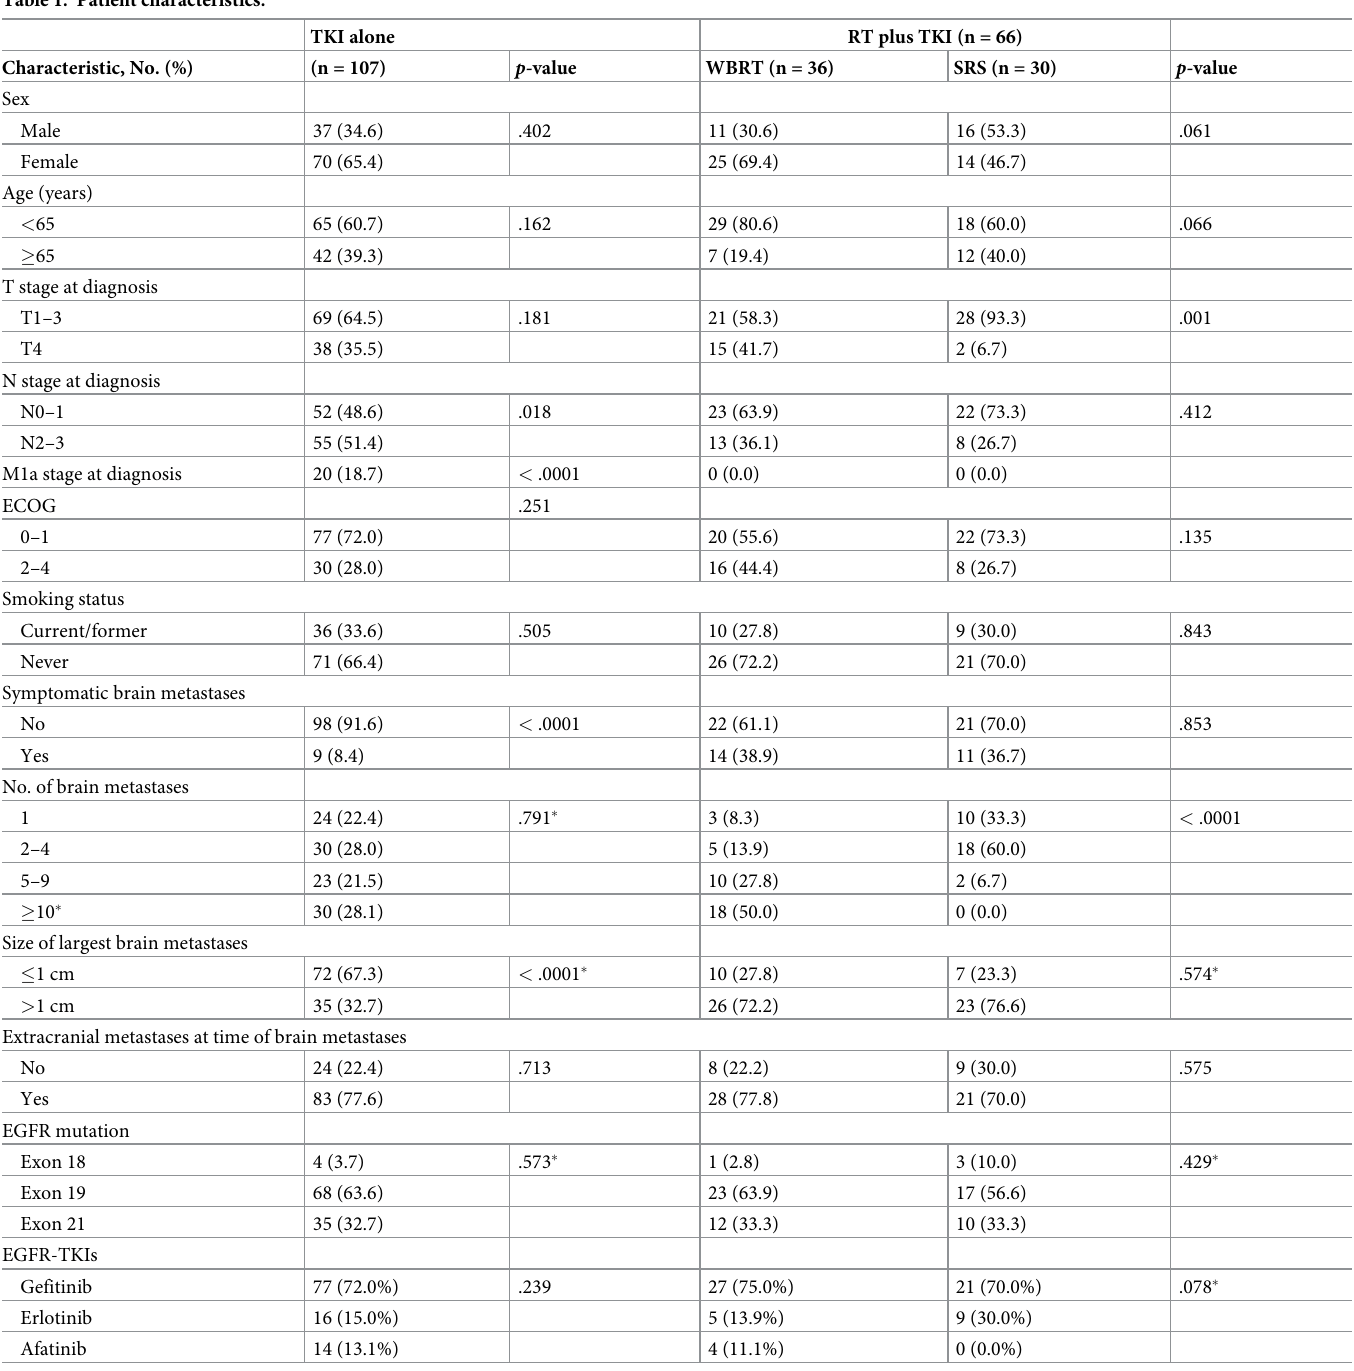
Table 1. Patient